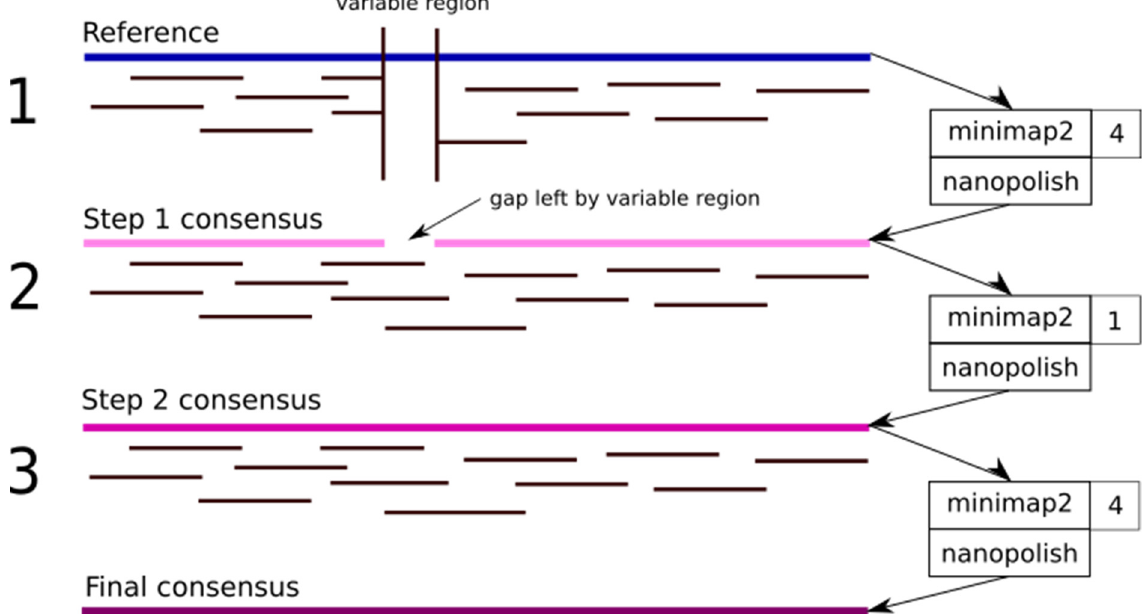
Figure 1. The HIV reference sequence contains many variable regions, particularly in the envelope gene (ENV), where conventional reference mapping may not be able to capture the high diversity. NanoHIV consists of three mapping steps: ( 1 ) An initial step with a standard gap penalty of 4, which results in a gap on the generated consensus where the variable region may be; ( 2 ) A remapping to the consensus with a lower gap penalty of 1, which bridges these variable regions; ( 3 ) A final mapping with the conventional gap penalty of 4 to remove any artefacts introduced by step 2.